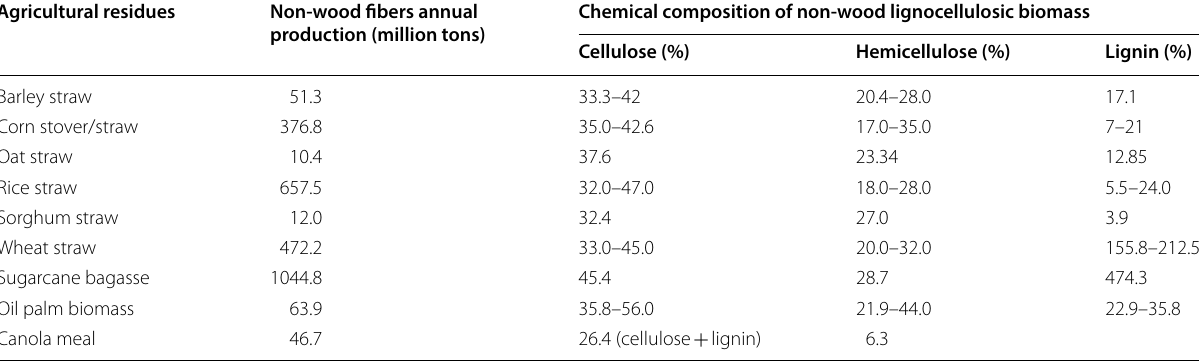
Table 4 Typical composition and global availability of agricultural residues. Modified from Ref. (Tye et al. 2016; Canola council of Canada